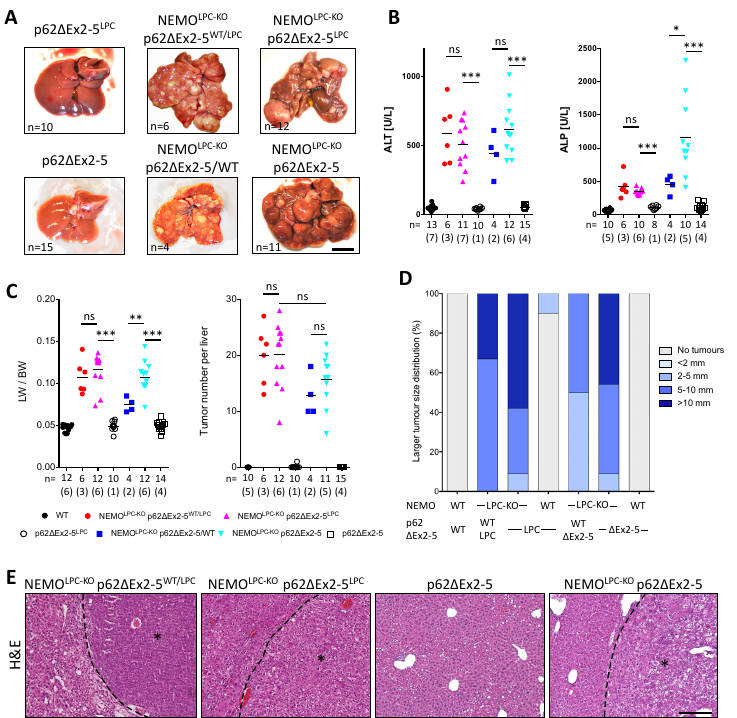
Figure 5. p62 Δ Ex2-5 expression aggravates liver disease and hepatocarcinogenesis in aged NEMO LPC-KO mice. ( A ) Representative liver images from 1-year-old mice with the indicated genotypes. ( B – D ) Serum ALT and alkaline phosphatase (ALP) levels ( B ), LW/BW ratio and tumor number per liver ( C ), and larger tumor size distribution ( D ) in 1-year-old mice with the indicated genotypes. Each symbol represents one mouse and horizontal lines indicate mean values. n indicates the number of analyzed mice, out of which the number of males is shown in brackets. ( E ) Representative images of H & E-stained liver sections from 1-year-old mice with the indicated genotypes. HCC areas are marked with an asterisk. ns, not significant; * p ≤ 0.05, ** p ≤ 0.01, *** p ≤ 0.005. Bars: ( A ) 1 cm; ( E ) 200 µm.